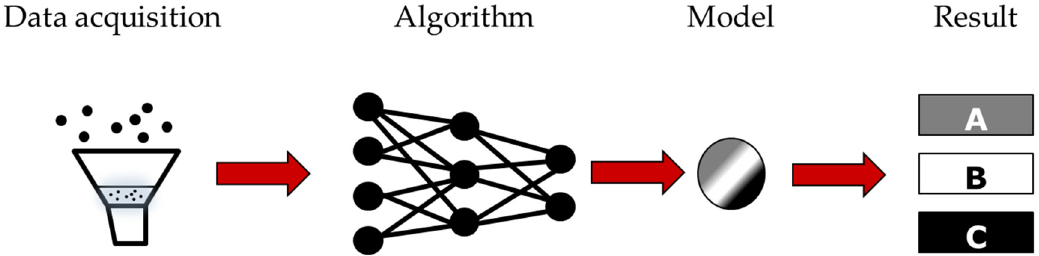
Figure 1. The flow chart of learning base.